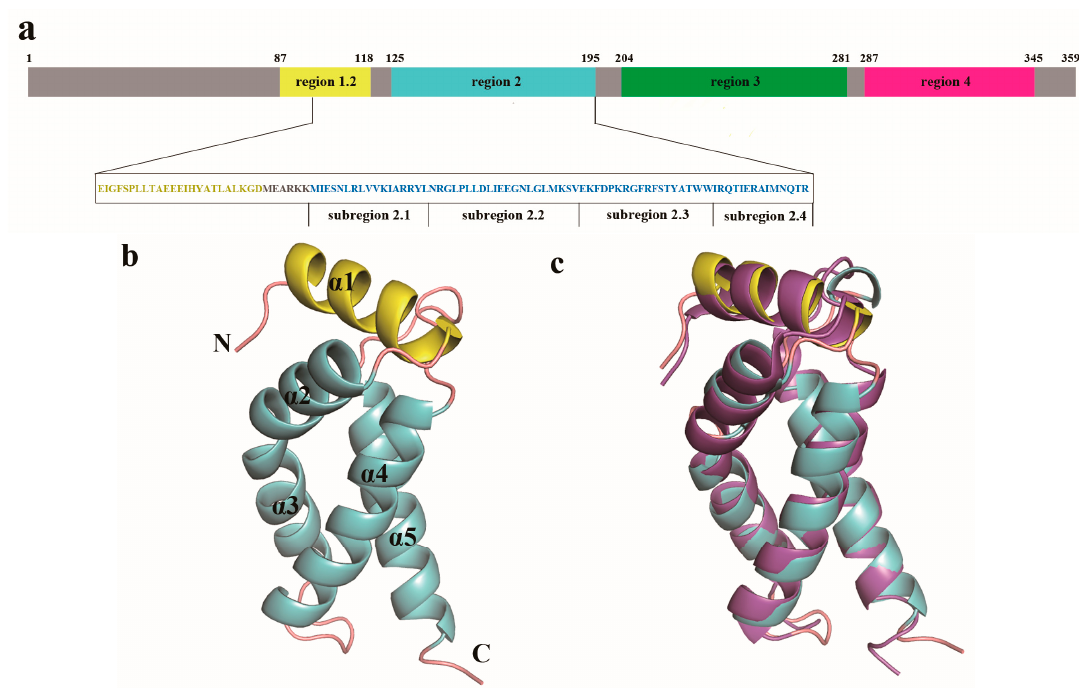
Figure 1. ( a ) A diagram to show the organization of Lp RpoS. ( b ) Cartoon representation of Lp RpoS 95 – 195 tertiary structure. The secondary structure elements are labeled to show the monomer. The secondary structure elements from region 1.2 and region 2 are shown in yellow and cyan,